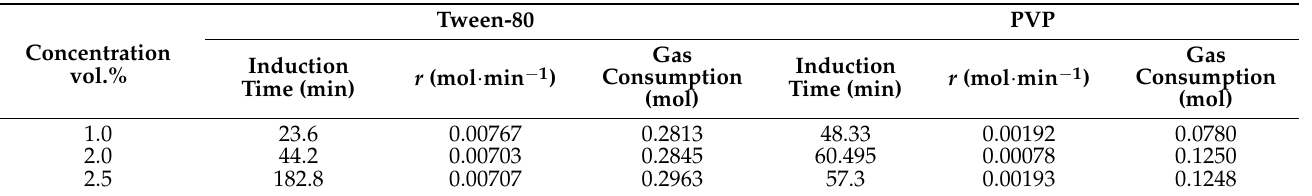
Table 3. Comparison of induction time, initial rate (r), and CH 4 consumption between PVP and the